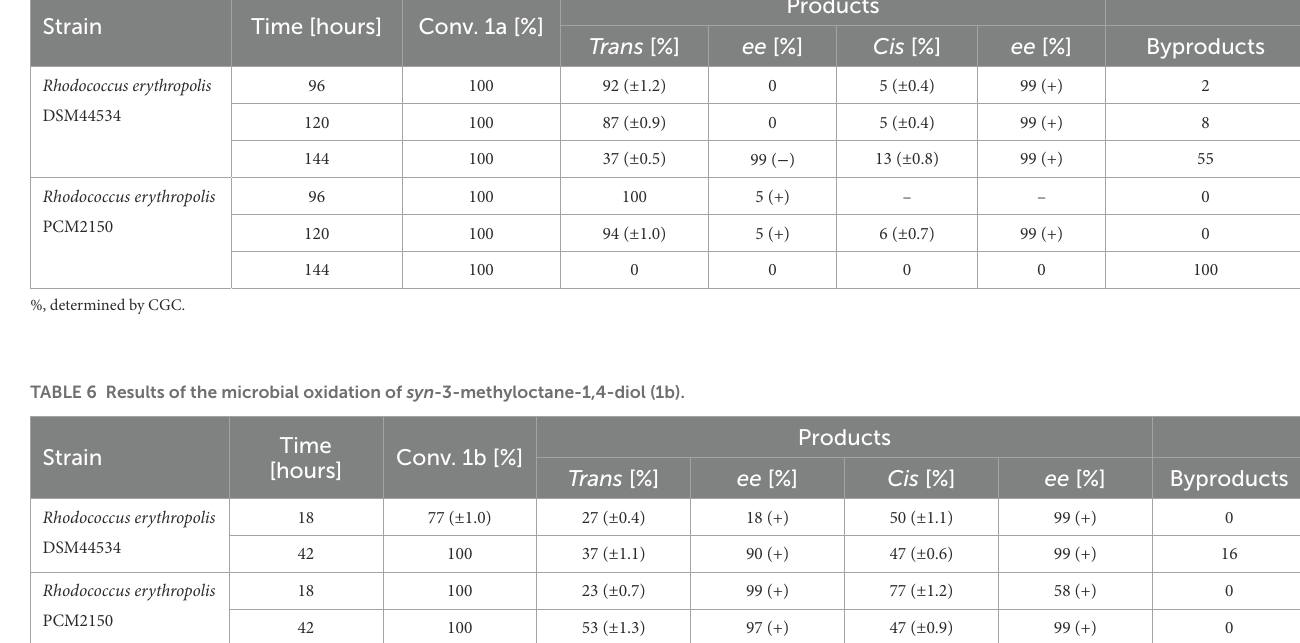
TABLE 5 Results of microbial oxidation of anti -3-methyloctane-1,4-diol (1a).